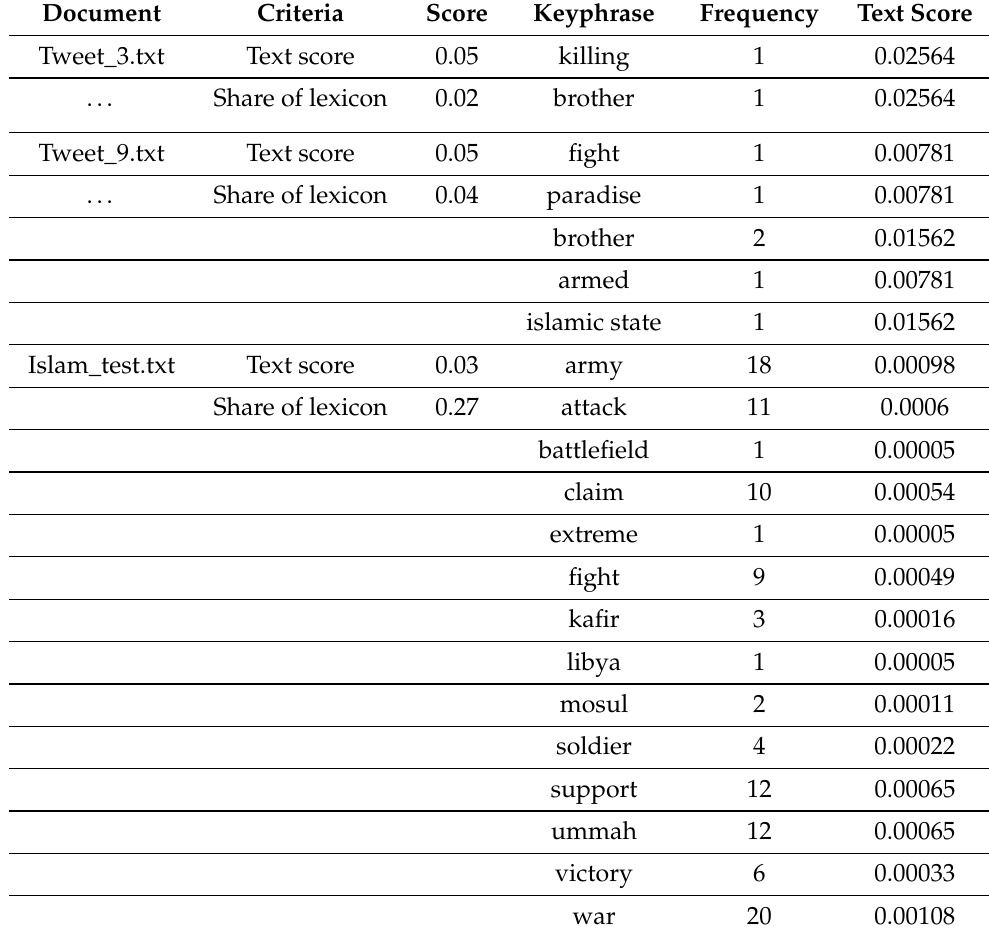
Table 1. The overall score of texts is explained to the user by showing the individual jargon key- phrases that occur in the text, an extract of which is presented here (unweighted lexicon